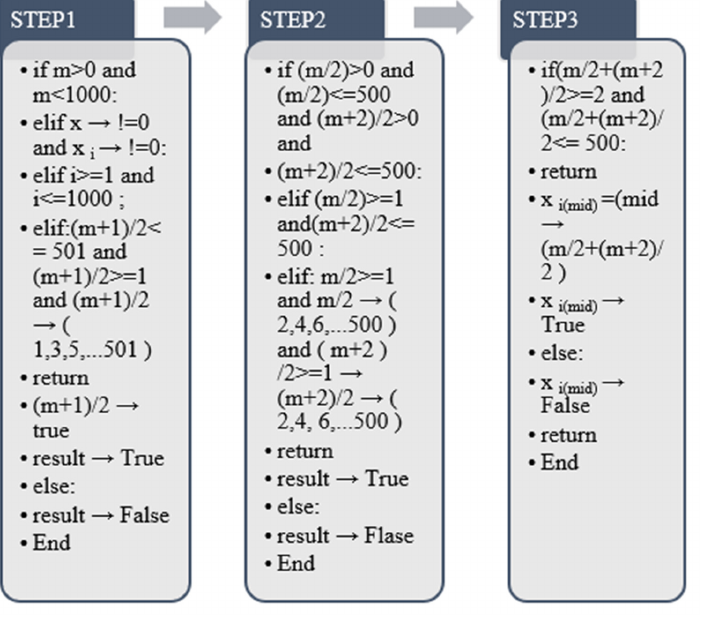
Figure 6. HATP sample collection algorithm output.